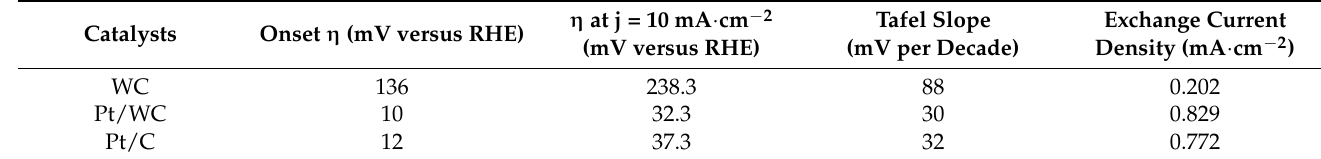
Figure 5. HER performances of WC, commercial Pt/C and Pt/WC catalysts in 0.5 M H 2 SO 4 solution: ( a ) Polarization curves at 2 mV·s −1 ; ( b ) Tafel plots by fitting LSV curves. Table 2. HER activities of different catalysts from LSV measurement in 0.5 M H 2 SO 4 solutions at room temperature.